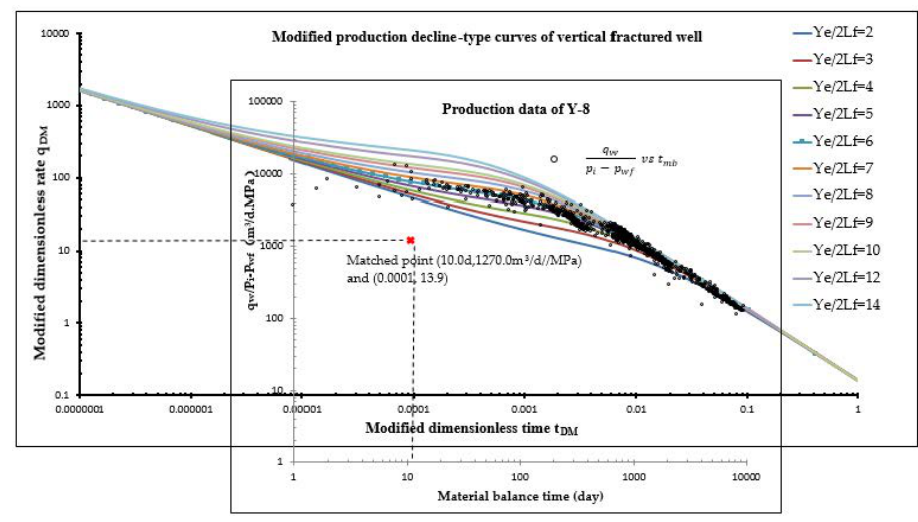
Figure 7. Type curves matching with the actual data of the vertically fractured well Y-8.